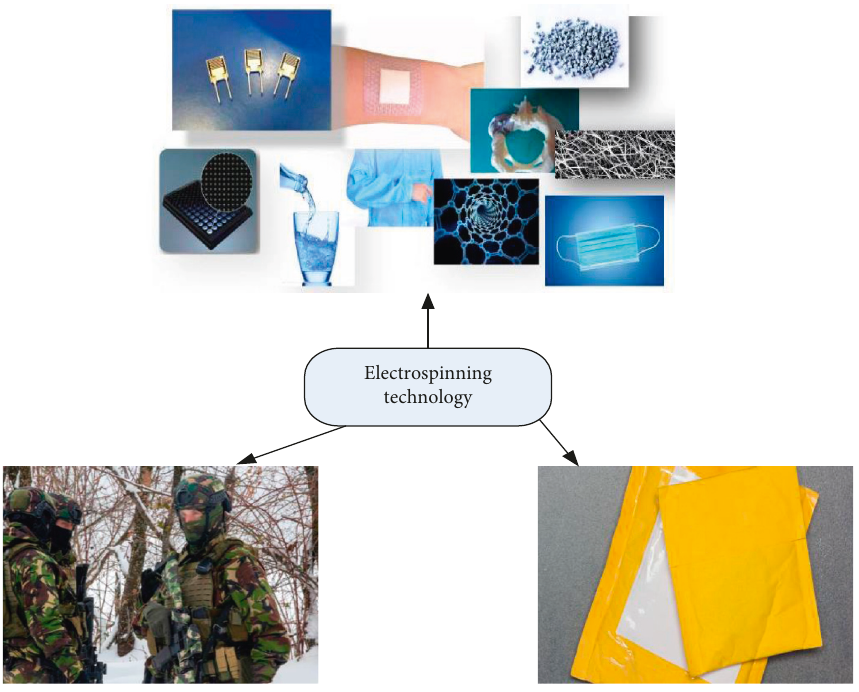
Figure 4: Application fields of electrospinning technology.